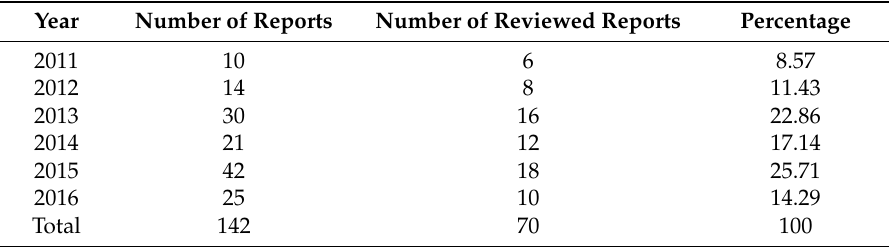
Table 6. Annual distribution of reviewed Niger Delta EIA